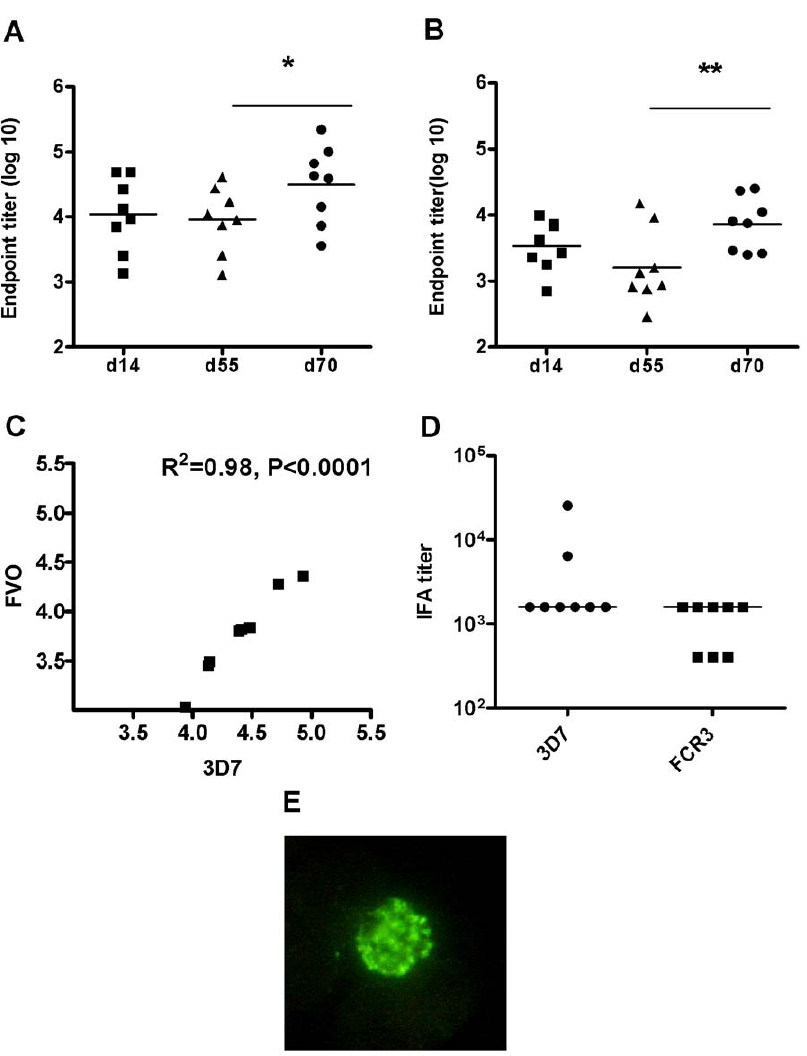
Figure 2. P.falciparum AMA1 specific total IgG responses induced by immunization in rabbits. New Zealand rabbits ( n =8) were immunized via the intradermal route with 5 6 10 10 vp of AdHu5-PfAMA1 (3D7) and boosted 8 weeks later with 5 6 10 7 pfu of MVA-PfAMA1 (3D7). The AMA1-specific antibody response against both homologous 3D7 (A) and heterologous FVO (B) PfAMA1 recombinant protein was measured in the serum at day 14 (post prime), 55 (pre boost) and 70 (post boost). Data show the responses from individual rabbits and the lines represent the median. The asterisk indicates a significant difference between the different time-points as analyzed by Wilcoxon signed rank test (* P # 0.05, ** P # 0.01). (C) The correlation between the 3D7 and FVO antibodies at day 70 was analysed using Pearson’s rank correlation. There was a highly significant positive correlation (R 2 =0.96, P # 0.0001). (D) IFA titers were measured using sera taken two weeks following the boost immunization. Individual IFA titers against 3D7 and FCR3 P. falciparum strains are shown with the median response (FCR3 AMA1 differs from FVO AMA1 by only a single amino acid substitution [18]). (E) When serum from immunized rabbits was used to label P. falciparum schizonts, typical AMA1-specific punctate apical staining of merozoites was